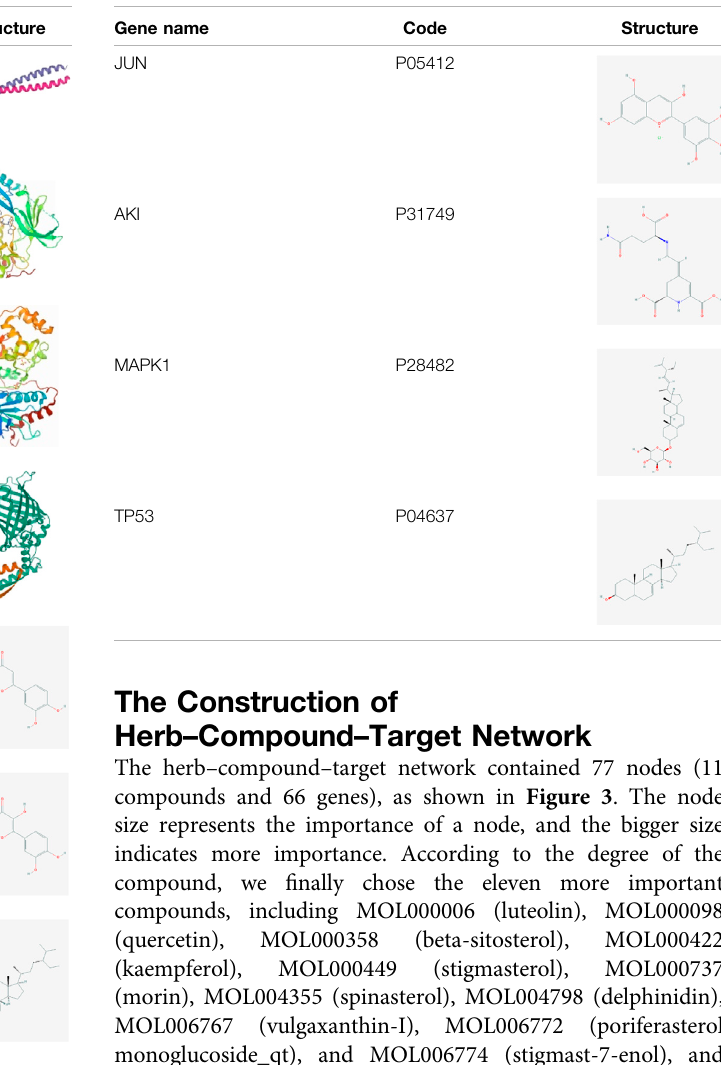
TABLE 2| Information for candidate targets from compounds of Prunella vulgaris . TABLE 3 | Information for targets gene from compounds of Prunella vulgaris